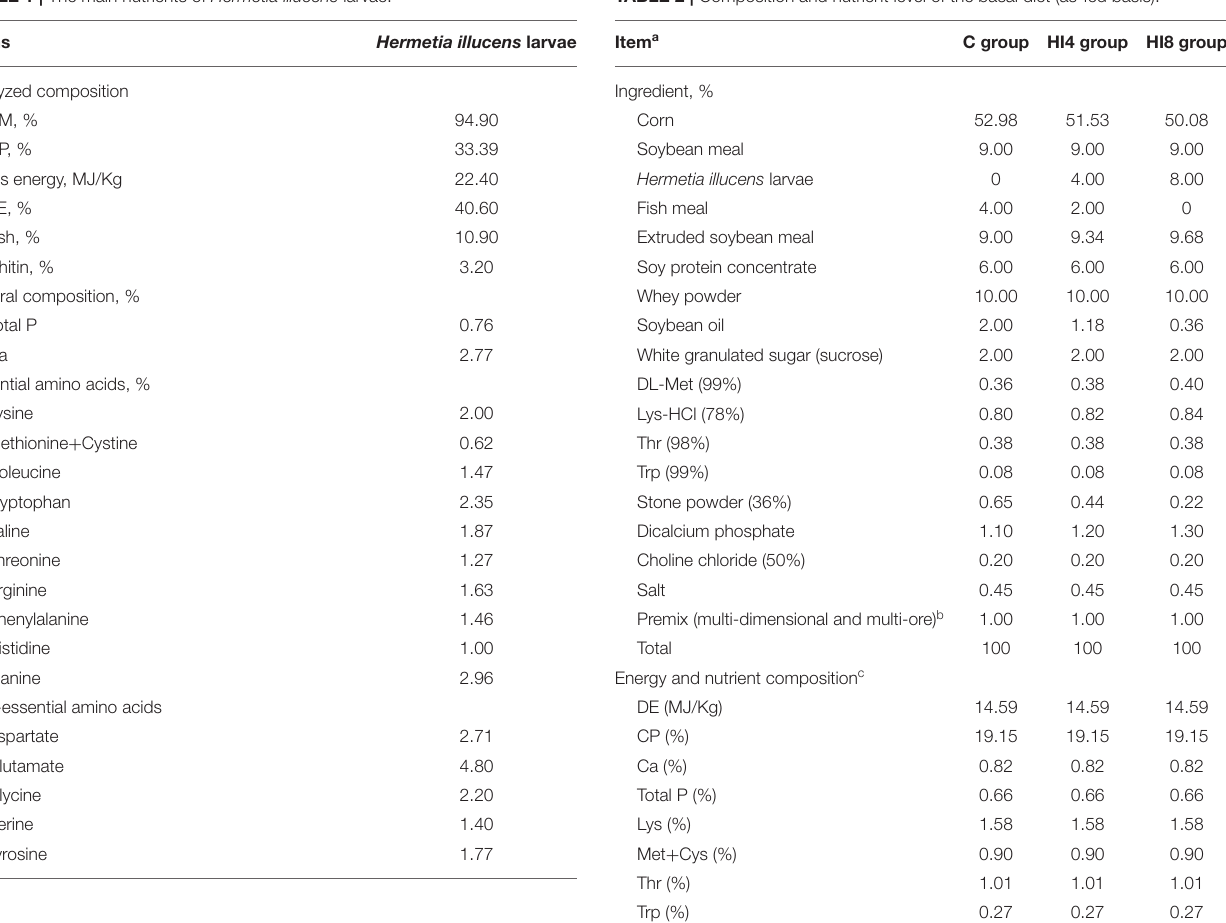
TABLE 1 | The main nutrients of Hermetia illucens larvae. TABLE 2 | Composition and nutrient level of the basal diet (as-fed basis).